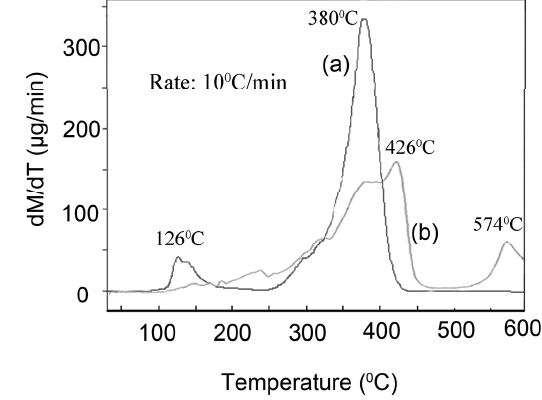
Figure 11. DTG curves of (a) pure PMMA, (b) PMMA/Sb 2 O 3 -Br compound.